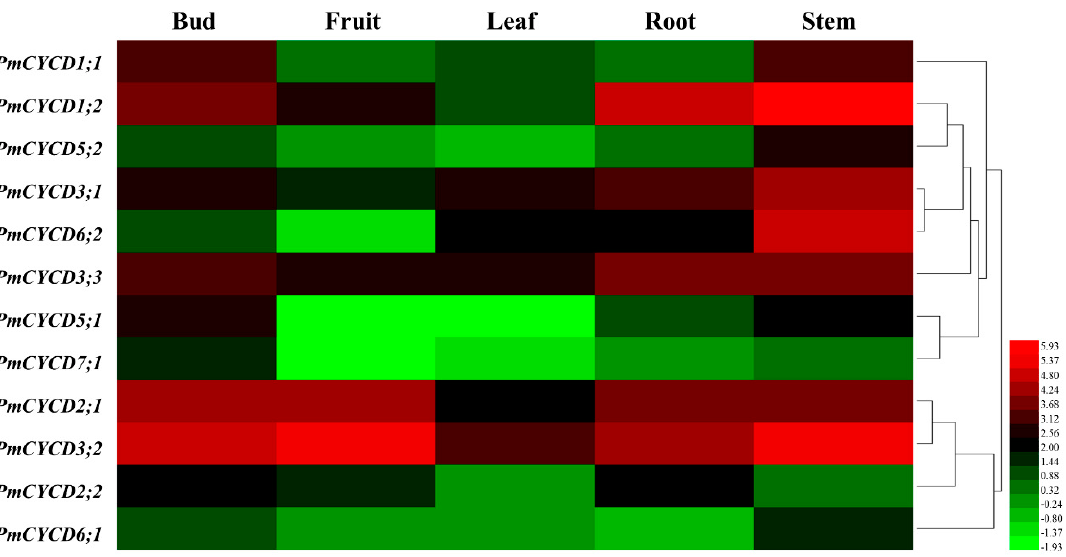
Figure 4. Hierarchical clustering of expression profiles of PmCYCDs in different organs. PmCYCD genes in five organs were collected from transcriptome data and the Log2 value of RPKM (RPKM> 0) was converted.